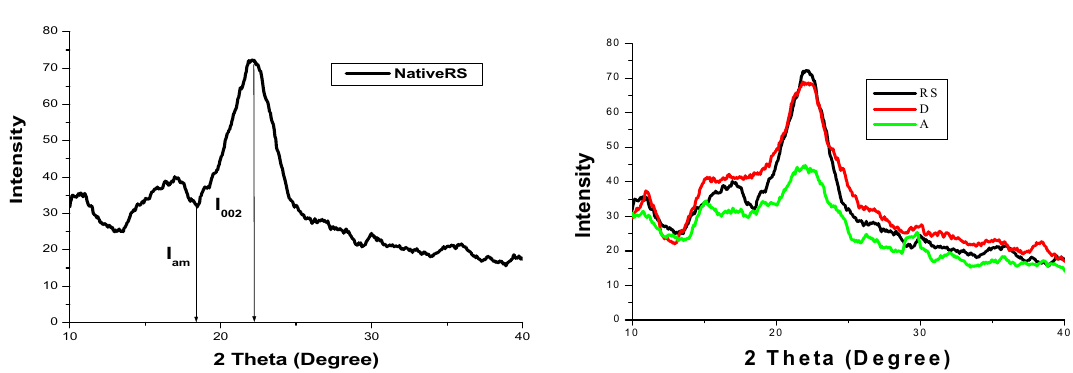
Figure 4. X-ray diffraction graphs for native ( RS ), PWW pretreated ( A ) and distilled water pretreated ( D ) rice